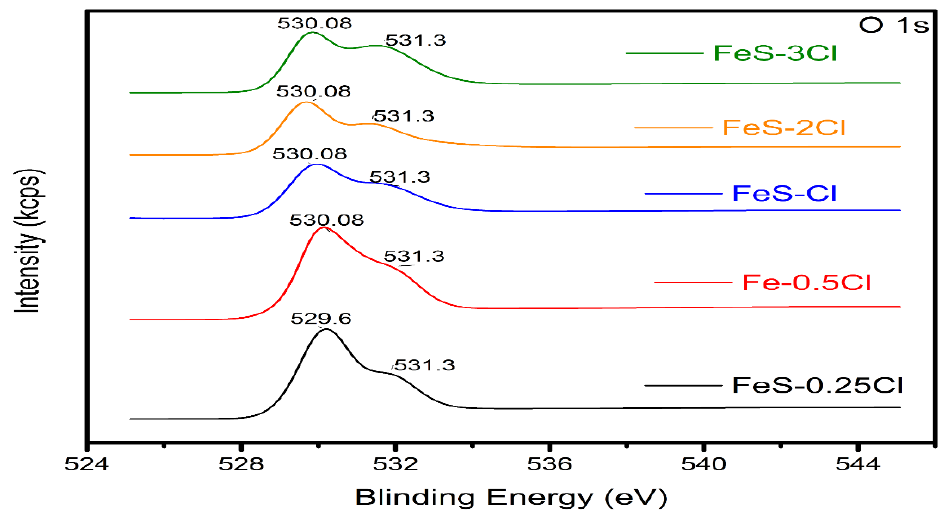
Figure 11. XPS O 1s diagram of all sulphur catalysts. The energy loss spectra of O 1s were used to determine the bandgap. The bandgap denotes the energy separation between the peak energy and the threshold of inelastic losses corresponding to electronic band-to-band transitions and excitation of plasma waves below the Fermi level with electrons in the VB [40]. The start of the energy loss spectrum Table 4. Band gap, valence band and conduction band sulphide catalyst. is obtained by linear extrapolation from the maximum negative slope segment to the background level [41]. The method of the energy loss peak was used for the corresponding O 1s spectrum. The Eg value of a large bandgap can be determined. Therefore, the procedure to obtain Eg includes a linear curve fit of the measured loss spectrum near the onset of inelastic losses [40]. The determination of the Eg for the materials with a large bandgap using the peak energy loss of the O 1s spectrum has been widely reported. In this context, XPS is useful to analyse the inelastic collisions that occur during photoexcitation and electron photoemission of materials.